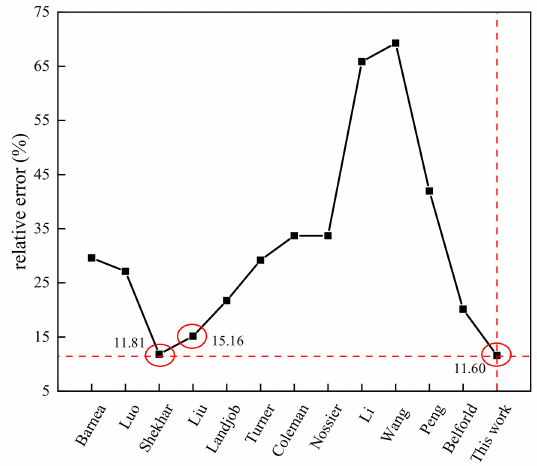
Figure 12. The relative error of different models.